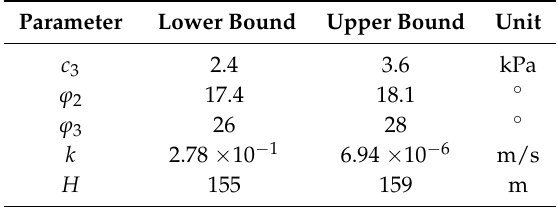
Table 2. Lower and upper bounds for the input parameters.